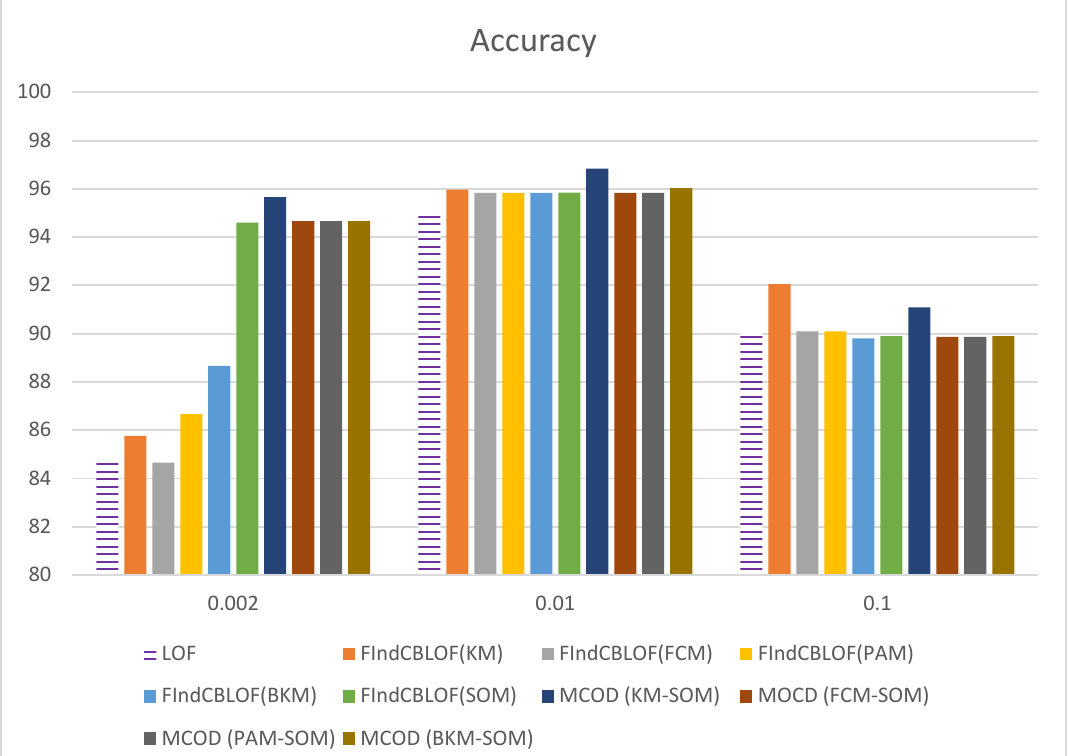
Figure 4. AUPRC (European Credit Dataset).